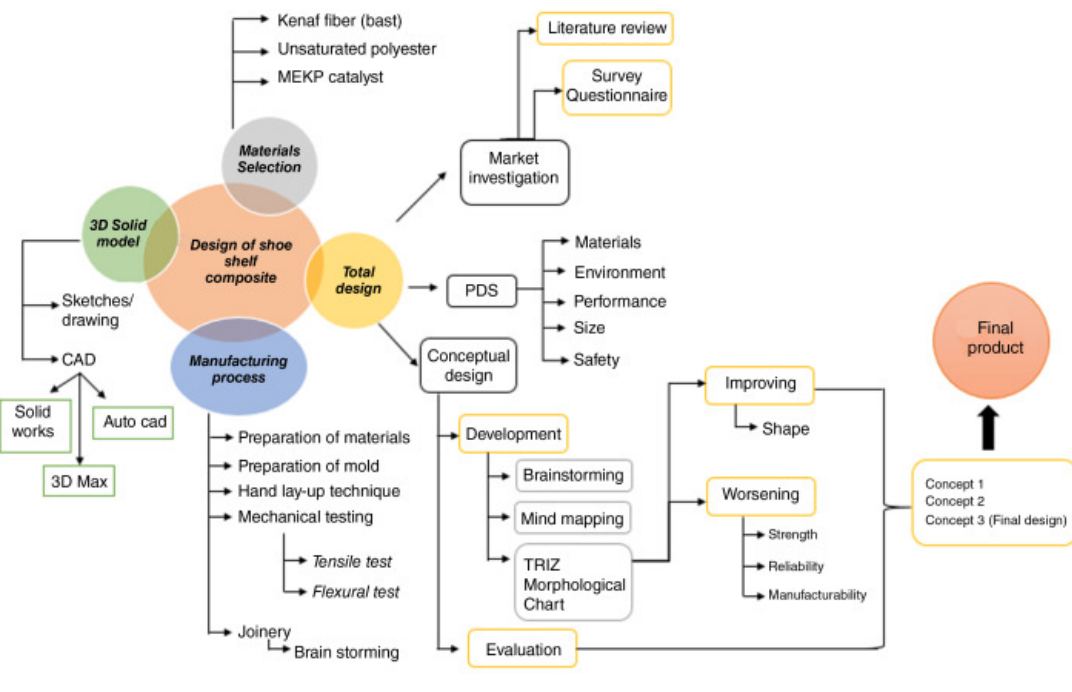
Fig. 5 System flow